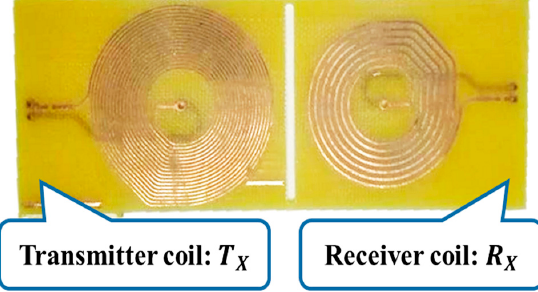
Figure 16. Made transmitter and receiver coil.